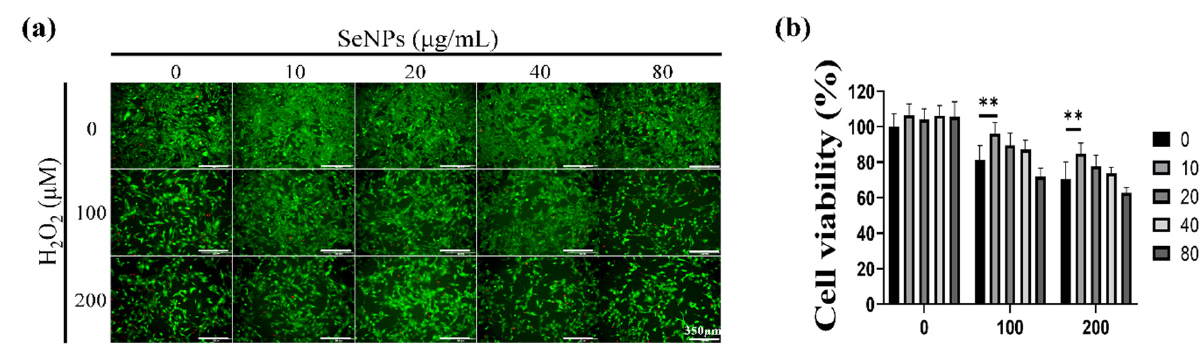
Figure 3. Cell viability was determined by live (green) and dead (red)-staining, and CCK-8 assays. After cell seeding for 24 h, C2C12 cells were analyzed using CCK-8 solution and stained using live/dead solution to evaluate viability. ( a ) Live/dead-staining following treatment with various SeNPs concentrations and H 2 O 2 . ( b ) Viability of C2C12 cells treated with various concentrations of SeNPs and H 2 O 2 . The statistical significance of ( b ) was calculated using two-way ANOVA, followed by a two-sided Dunnett’s multiple comparison test compared to untreated groups (scale bar = 350 µm). ** Represents p < 0.01, * compared with the SeNPs and H 2 O 2 untreated groups.